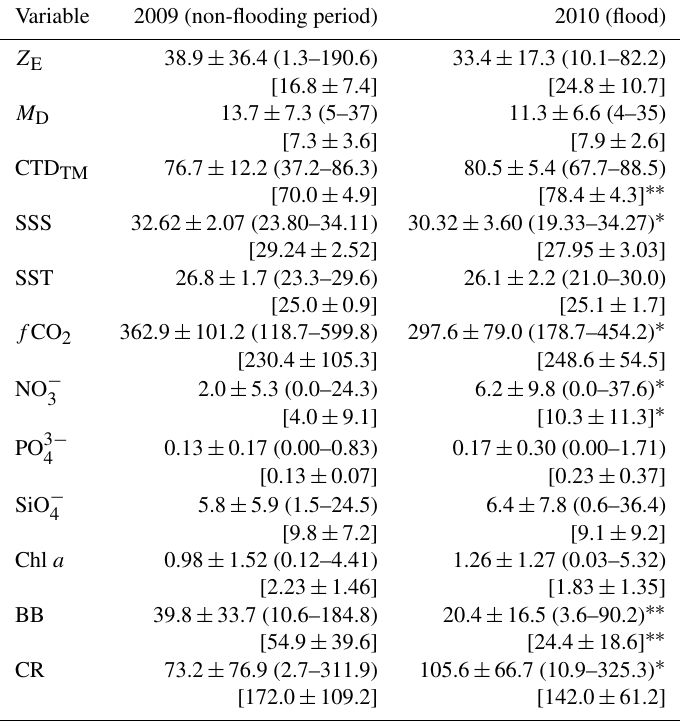
Table 1. The mean ± SD values for the different variables measured in the surface water of the ECS during non-flooding (2009) and flooding (2010) periods with the range of values in parentheses. The mean ± SD values for stations in the area of the Changjiang diluted water (CDW) region are in brackets. Variables include transparency (CTD TM ; %), salinity (SSS), temperature (SST; ◦ C), fugacity of CO 2 ( f CO 2 ; µatm), nitrate concentration (NO − ; µM), phosphate concentration (PO 3 − ; µM), silicate concentration (SiO − ; µM), chlorophyll a concentration 3 4 4 (Chl a ; mgChlm − 3 ) , bacterial biomass (BB; mgCm − 3 ) , and plankton community respiration (CR; mgCm − 3 d − 1 ) . The euphotic depth ( Z E ; m) and mixed layer depth ( M D ; m) are also shown for each year. Mann–Whitney rank-sum tests were used to identify temporal differences. For reference, it should be noted that the difference between the CDW zone and the other regions in the ECS in each year was significant for most of the variables ( p <0.05), except nitrate and phosphate in